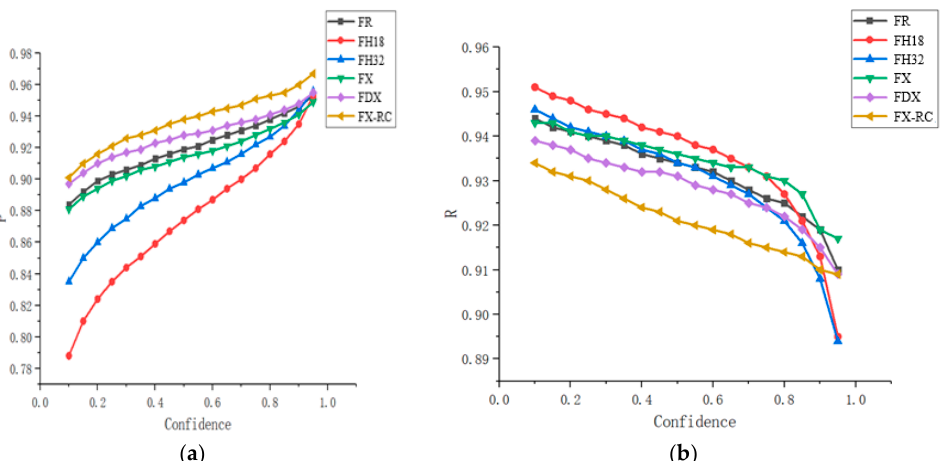
Figure 6. ( a ) Accuracy curves of the six experimental schemes; ( b ) recall curves of the six experimental schemes.